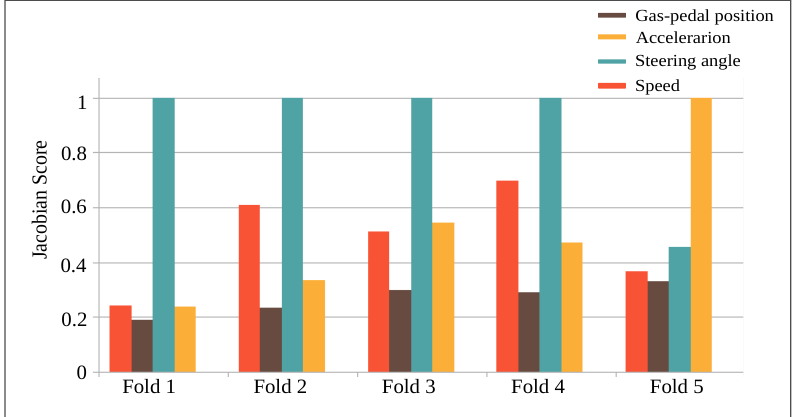
Figure 8. Jacobian score for CNN of five cross-validation folds of four signals. A higher Jacobian score indicates that the sensor channel contributed to the learning of more discriminative features. The y axis represents the normalized magnitude of the Jacobian score for each sensor